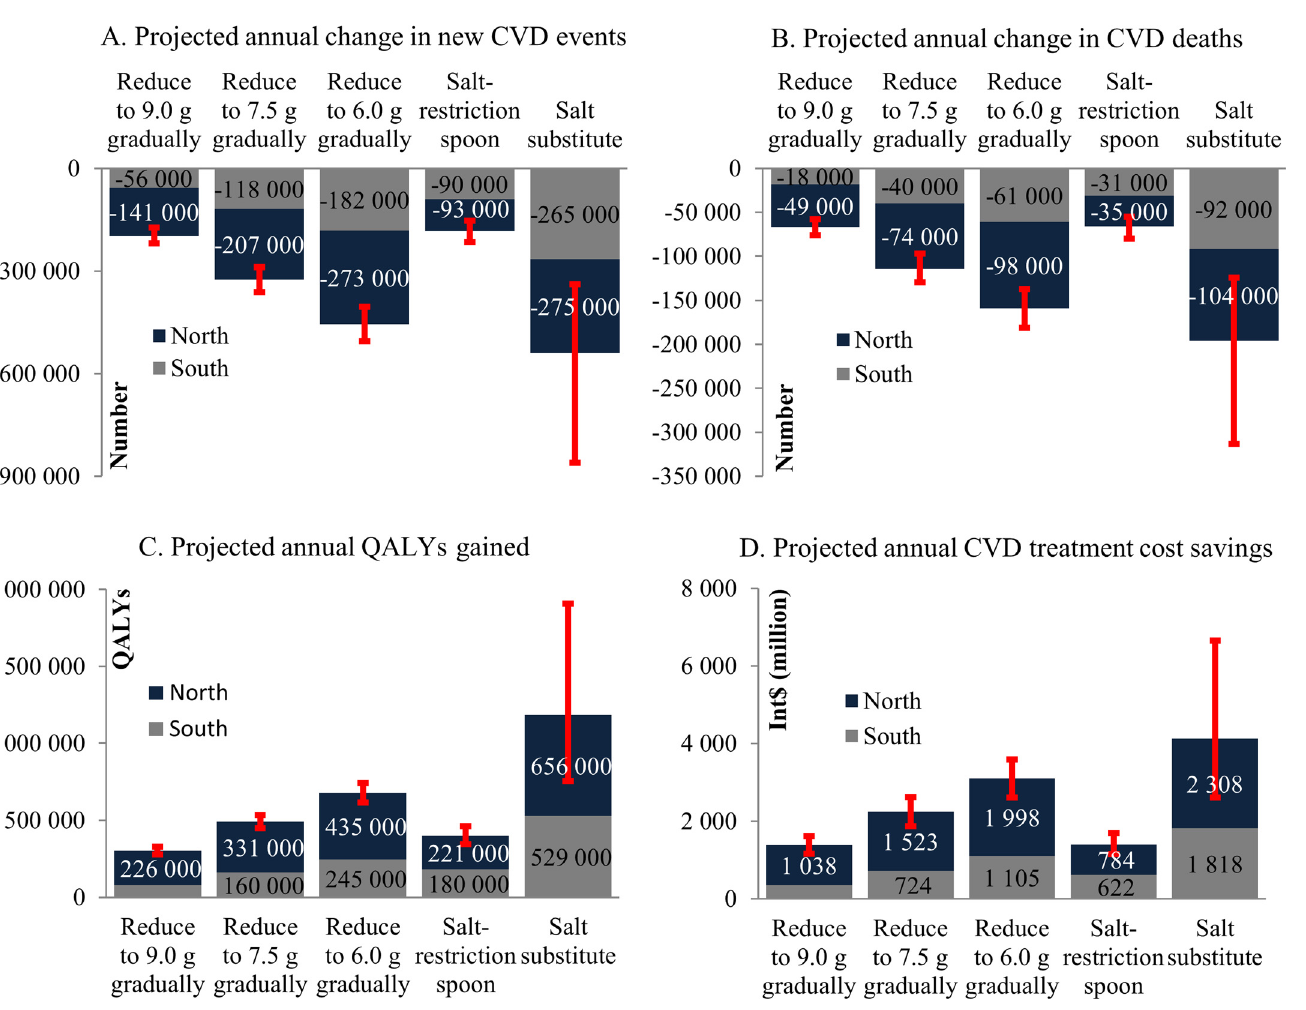
Fig 2. Annual benefits of CVD prevention projected for salt intake interventions by region in China. Bars represent the main simulation point estimate. I bars indicate 95% uncertainty intervals of the gained benefit among the overall population from 1 000 probabilistic simulations. CVD, cardiovascular disease; Int$, international dollars; QALY, quality-adjusted life